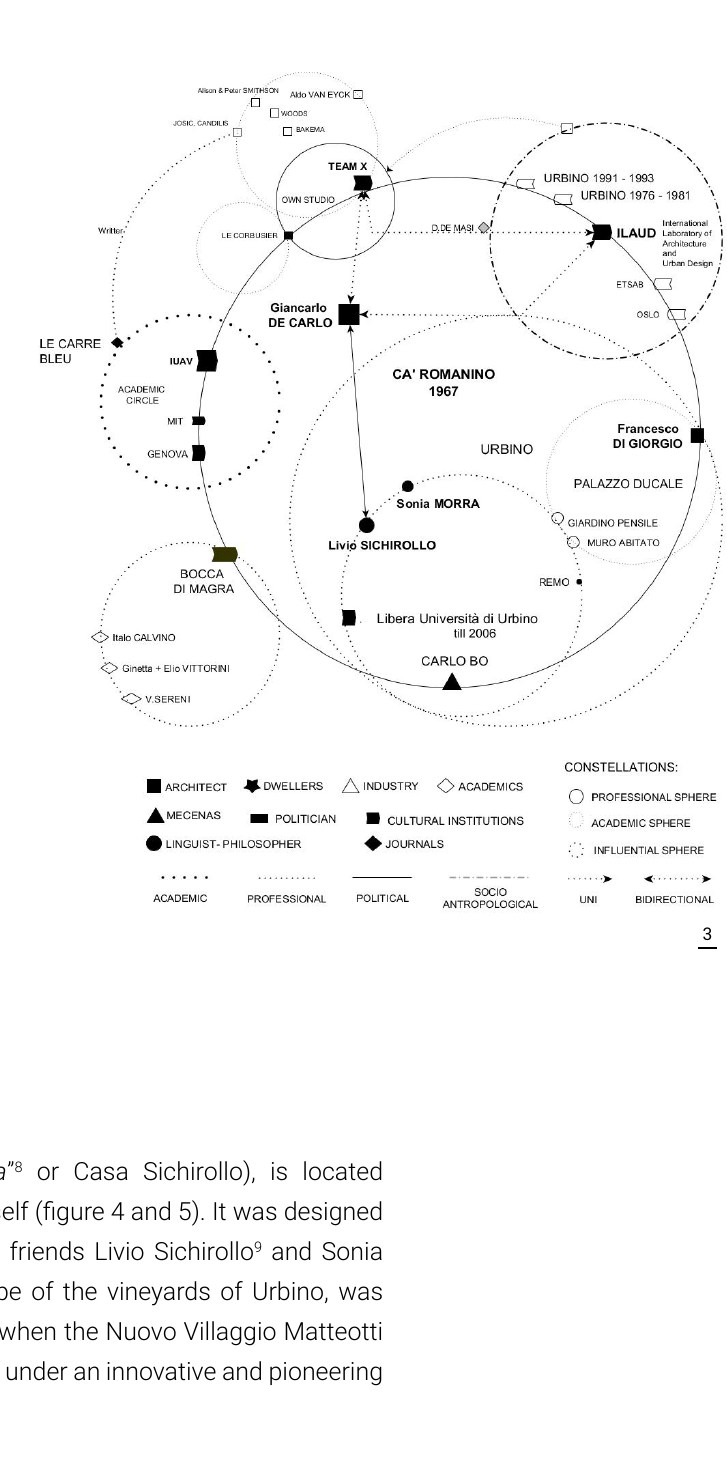
Constellation showing different spheres in relation to Ca’ Romanino and Giancarlo De Carlo. Source: Own elaboration from the reading of references and field work in